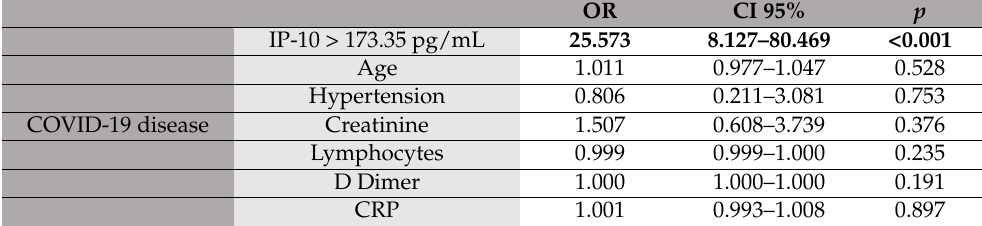
Table 3. Multivariate model showing the association between high IP-10 levels and risk of COVID-19 infection. CI, confidence interval; OR, odds ratio; CRP, C reactive protein. The bold is to indicate statistical